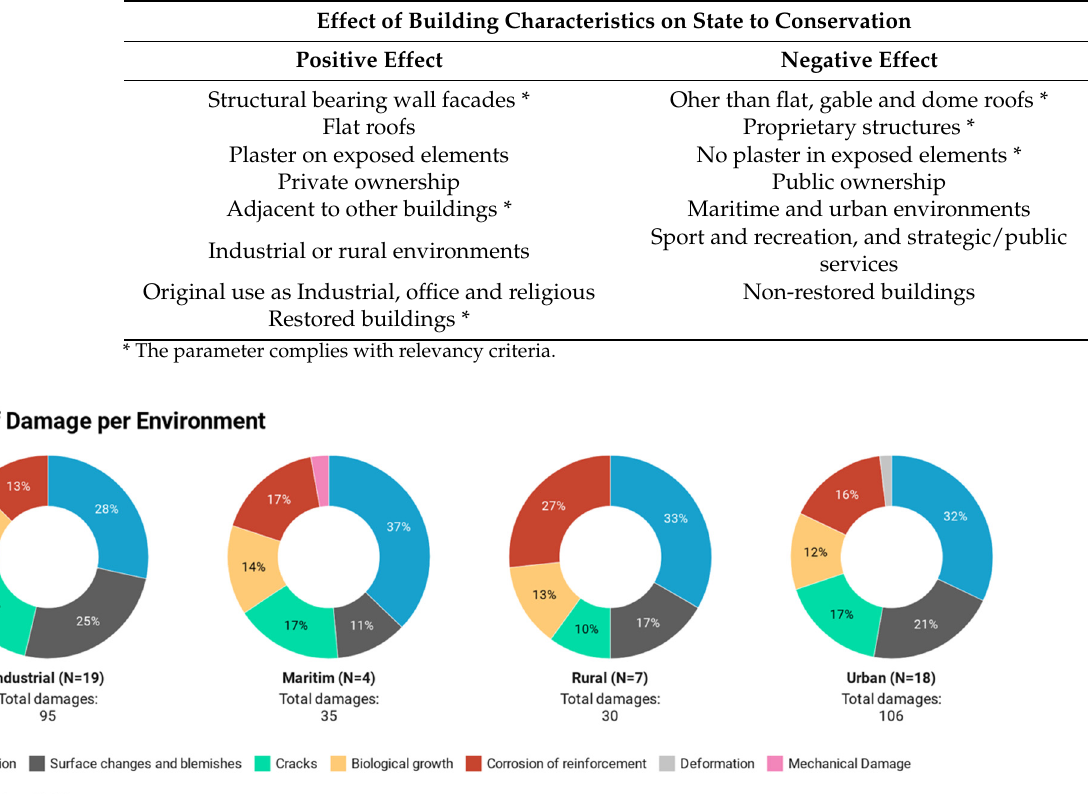
Table 4. Factors influencing positive and negative trends in building state of conservation.